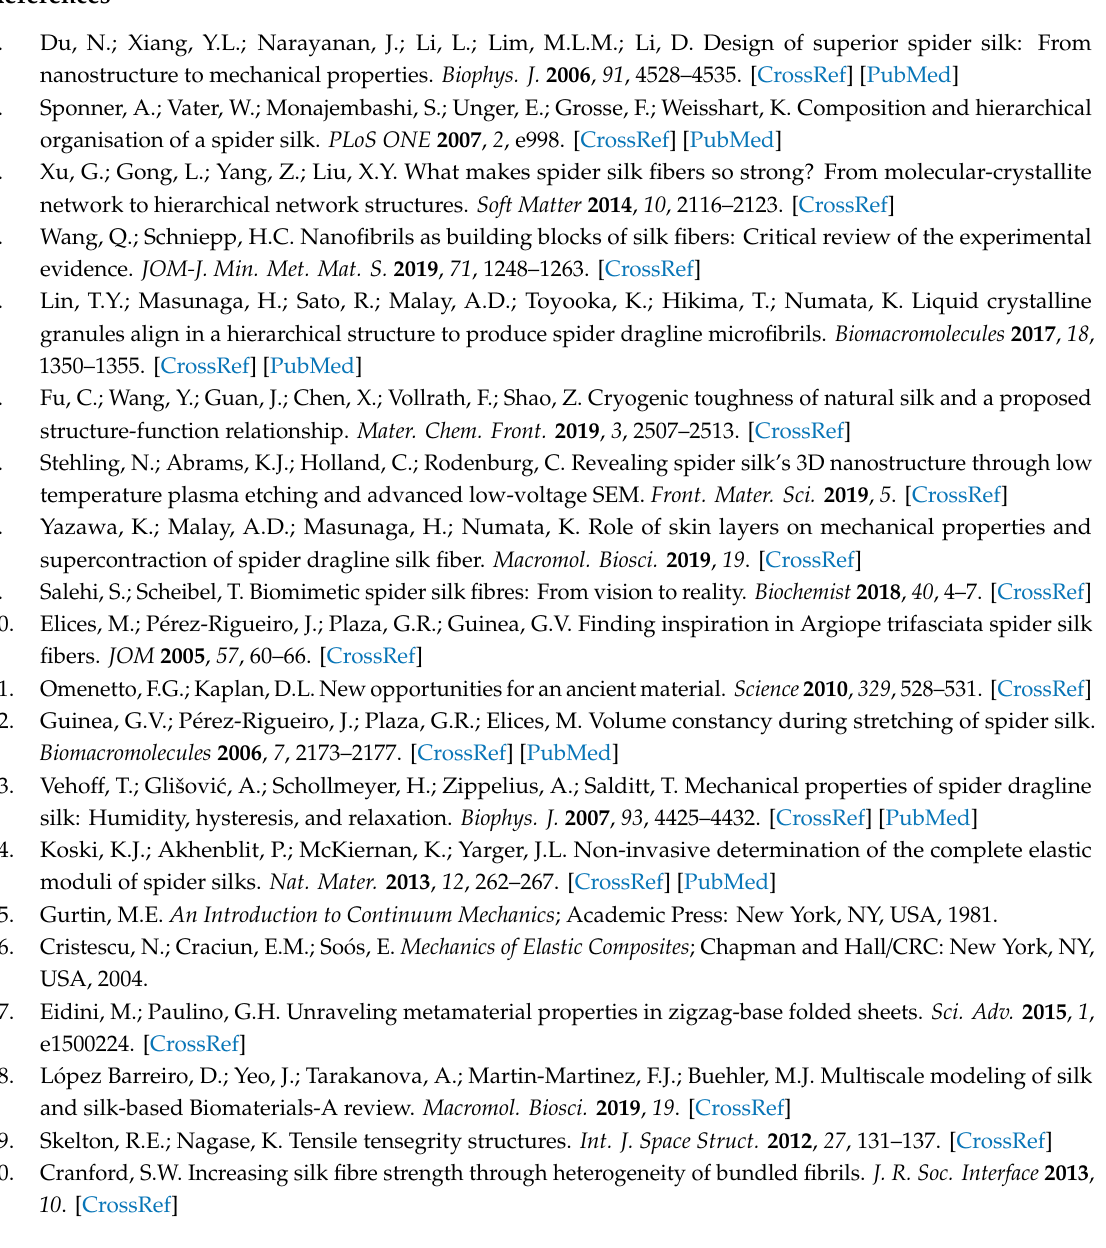
1.5 min; Figure S2 left: untreated fibre, right: after 1 min exposure to plasma; Figure S3 left: after 2min exposure to plasma, right: after 6min exposure to